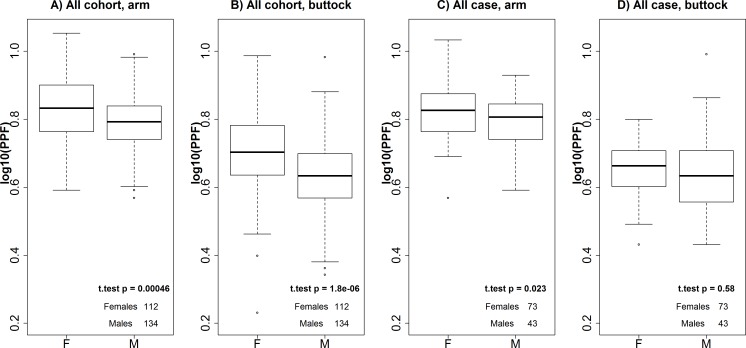
Comparison between skin color measurements in females and males.Arm (A) and buttock (B) measurements in females and males of the cohort. Arm (C) and buttock (D) measurements of female and male cases. P-values were calculated using Welch’s two sample t-test.